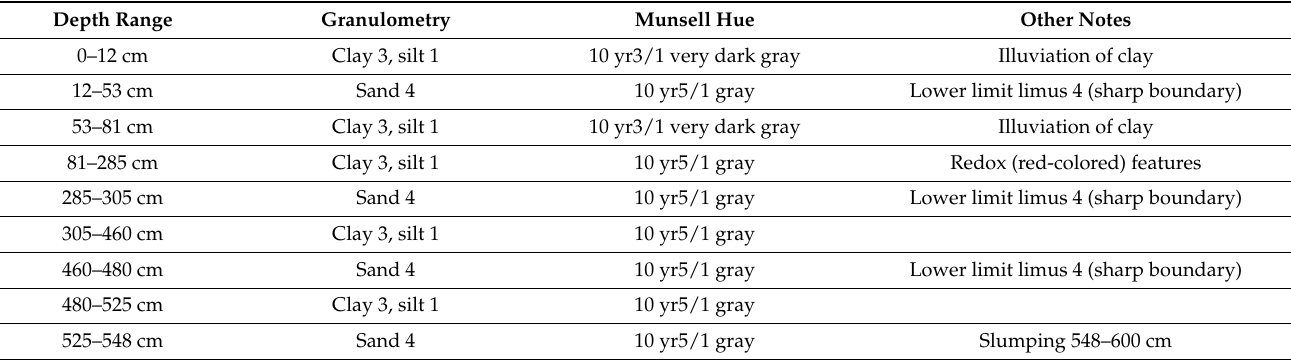
Table 4. Troels-Smith’s description of Swan Lake (SL) sediments